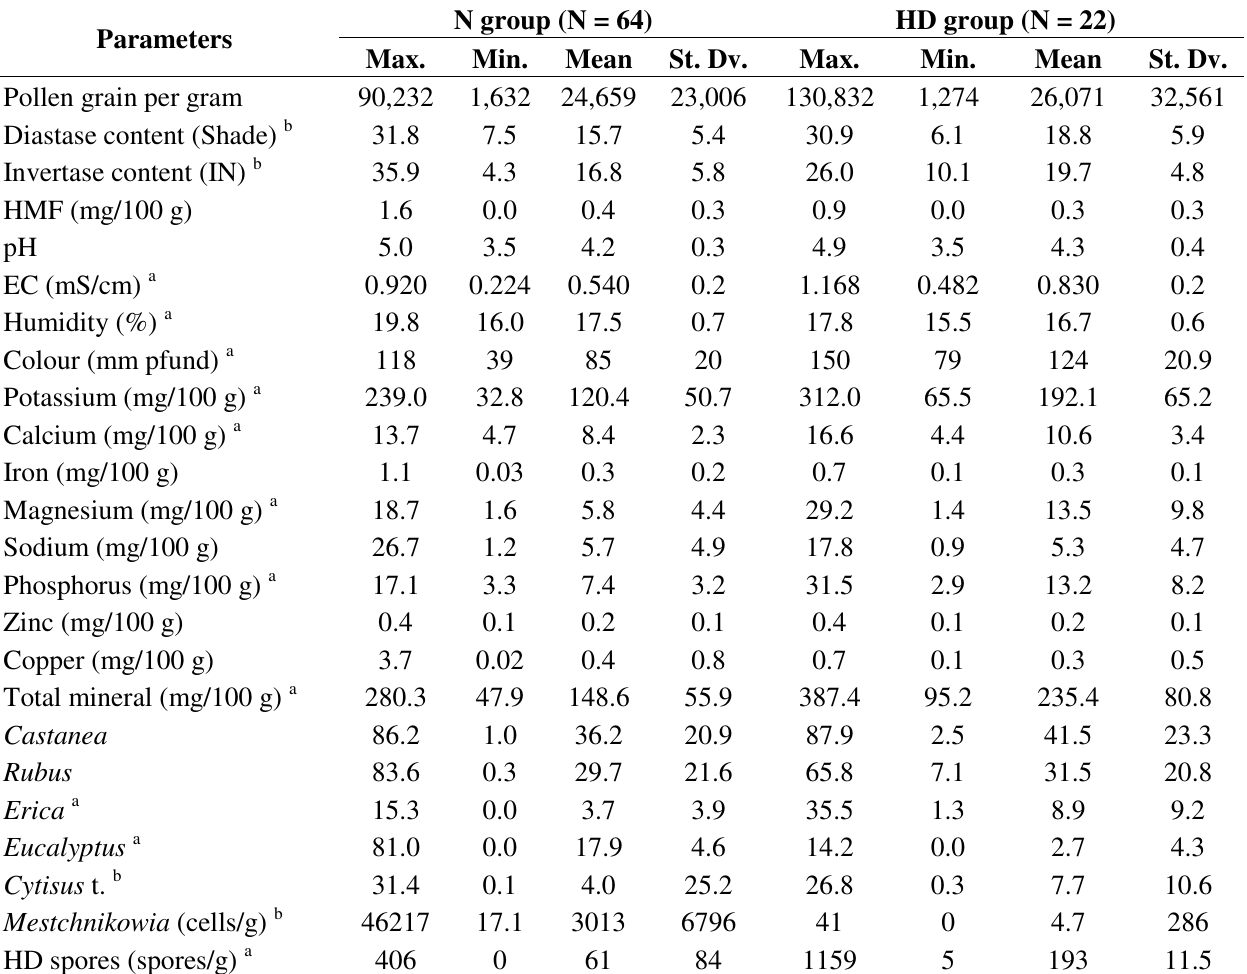
Table 6. Descriptive statistical analysis of the groups established by cluster analysis.